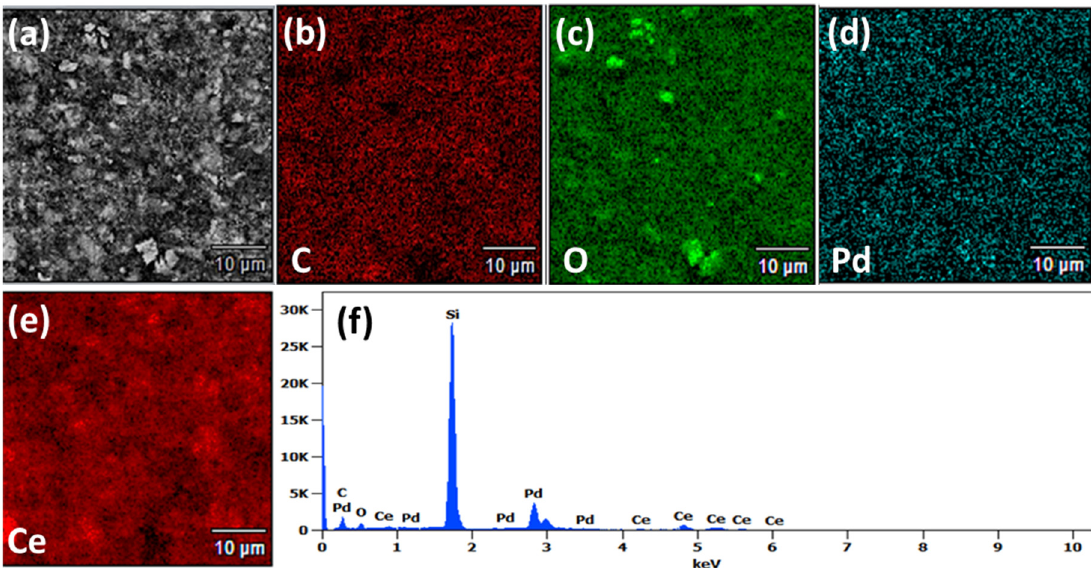
Figure 3. ( a ) SEM image and EDS mapping of ( b ) carbon, ( c ) oxygen, ( d ) palladium, and ( e ) cerium, and ( f ) EDS spectrum of the CeO 2 -Pd-PDA/rGO heterojunction nanocomposite.